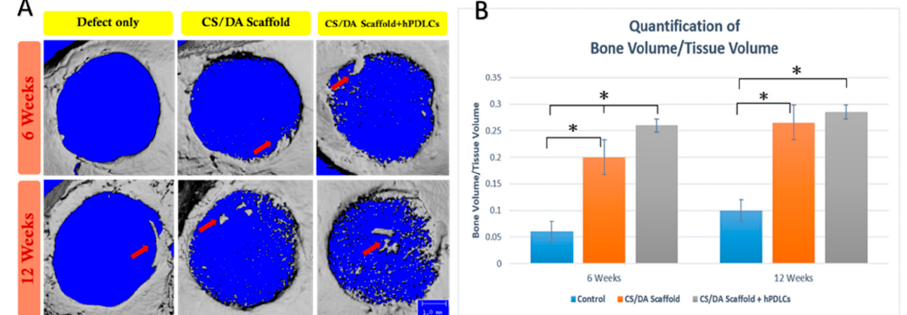
Figure 3. Effect of chitosan/dicarboxylic acid (CS/DA) scaffold on bone regeneration in mouse calvarial defects as assessed by micro-CT scanning. ( A ) New bone formation in mouse calvarial defect (red arrows). ( B ) Quantification of bone volume related to tissue volume (BV/TV). One-way ANOVA, Tukey HSD post hoc test, * p = 0.05.